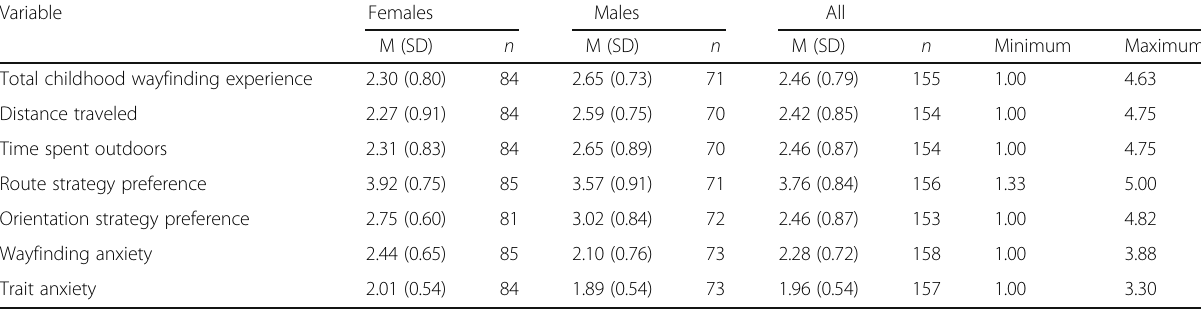
Table 2 Means and standard deviations of the variables by participant sex